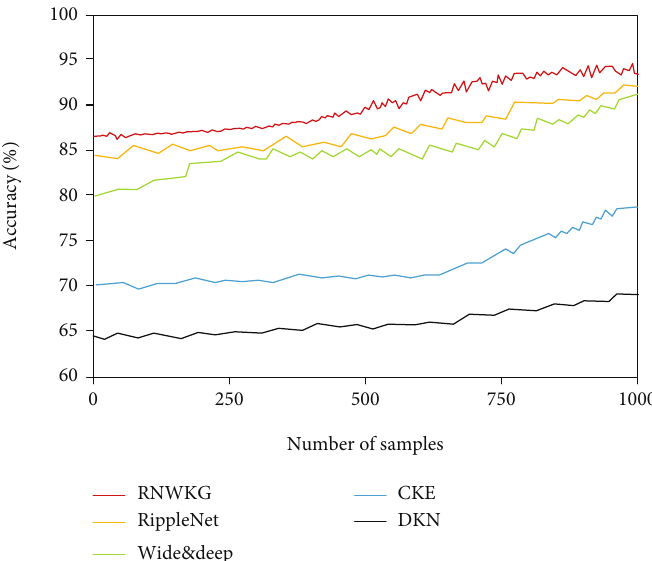
Figure 7: Comparison of accuracy of fi ve models in Book-Crossing.